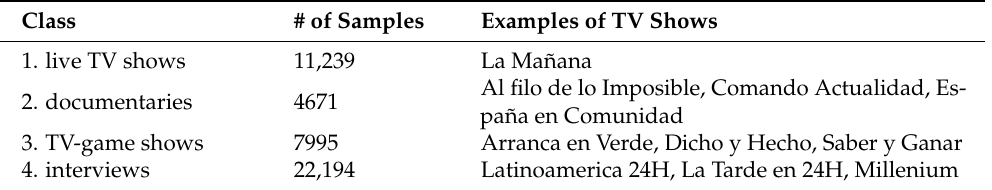
Table 1. Description of the domain classes according to the number of samples and the characteristics of the TV shows. More details related to the TV shows are described in the RTVE2020 Database specifications